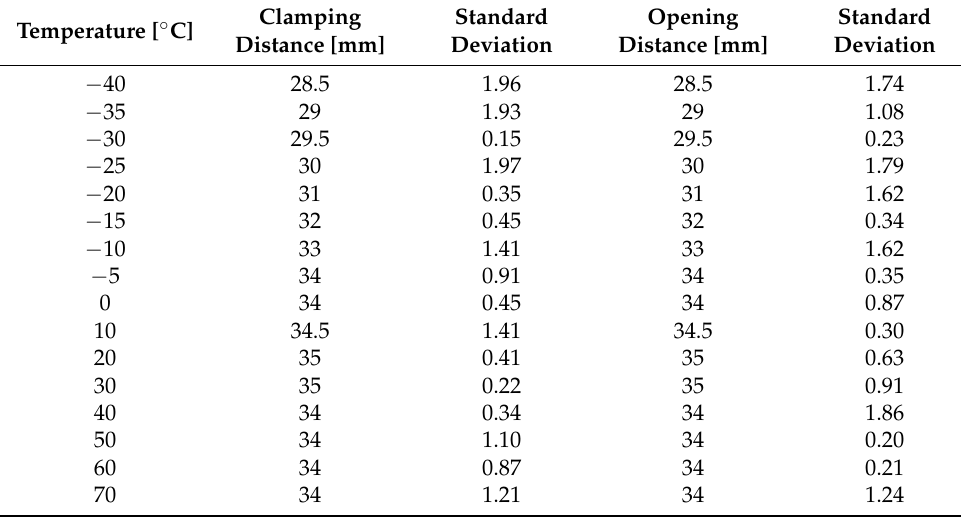
Figure 5. Magnetic contacts during experimental testing, ( A )-MAS 203, ( B )-MAS 333, ( C )-SA 220, ( D )-USP 131, ( E )-USP 500. Table 1. MAS 203 magnetic contact on and off values during experimental